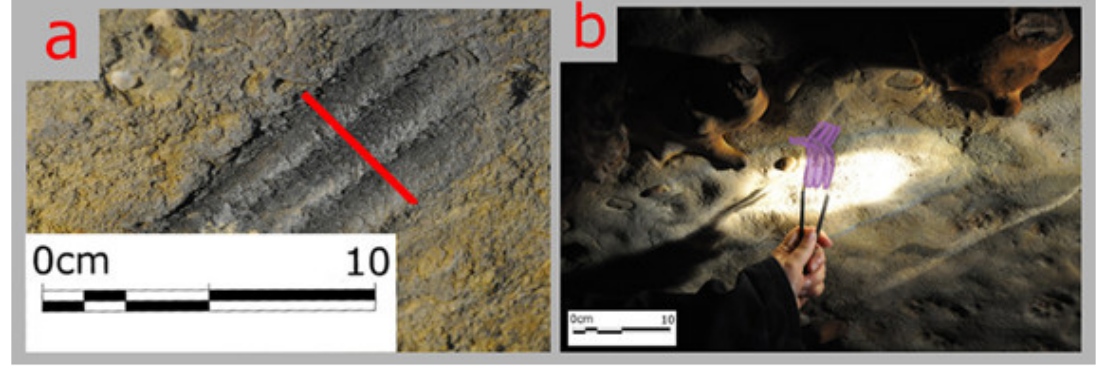
Figure 2. Measurements of finger flutings: (a) the location of accurate measurement on a fluted unit, and (b) measuring of the unit in